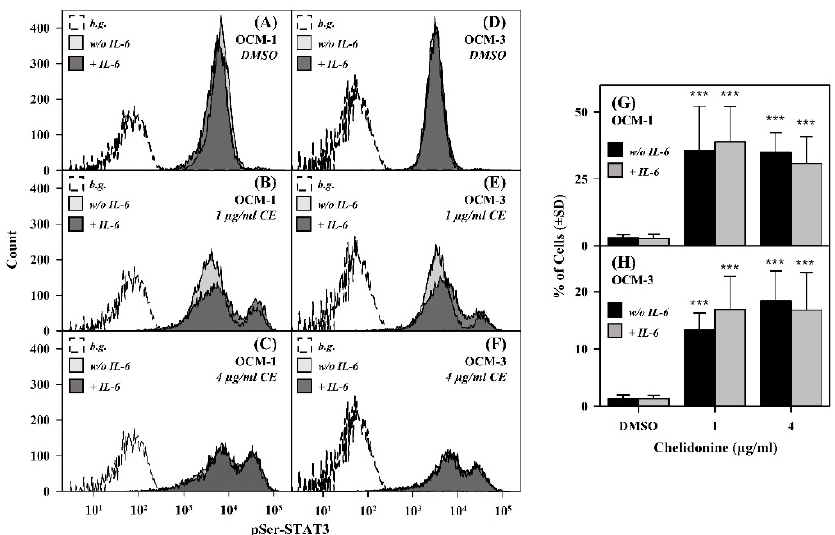
Figure 2. Serine phosphorylation of STAT3 is enhanced by chelidonine in a significant portion of OCM-1 and OCM-3 cells. ( A – F ) Representative flow cytometric intensity histograms demonstrate cell-by-cell distribution of pSer-STAT3 levels in DMSO- and chelidonine-treated cells. The thick black line and the filled grey histograms belong to IL-6-stimulated and unstimulated cells, respec- tively, whereas the dashed line histograms represent unlabeled cells (background). ( G , H ) Bar charts demonstrate the fraction of cells with increased levels of pSer-STAT3 for DMSO- and chelidonine- treated OCM-1 and OCM-3 cells. Grey and black bars represent IL-6-stimulated and unstimulated cells, respectively. Percentages are expressed as the mean ± SD values of at least three independent